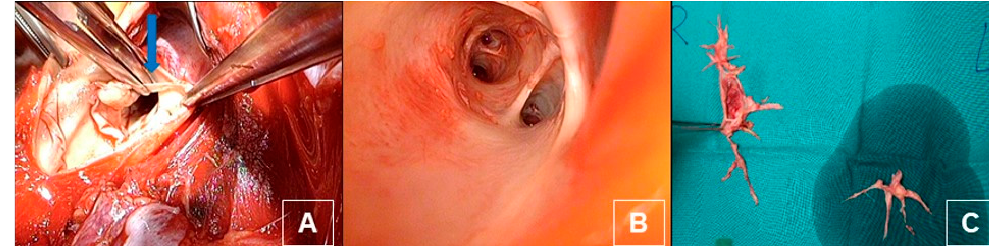
Figure 14. ( A ) Intraoperative dissection of the intima and media of the pulmonary artery and the branches (blue arrow). ( B ) After dissection with view on the middle and lower lobe artery. ( C ) Postoperative thrombendarterectomy sepcimen from both sides.